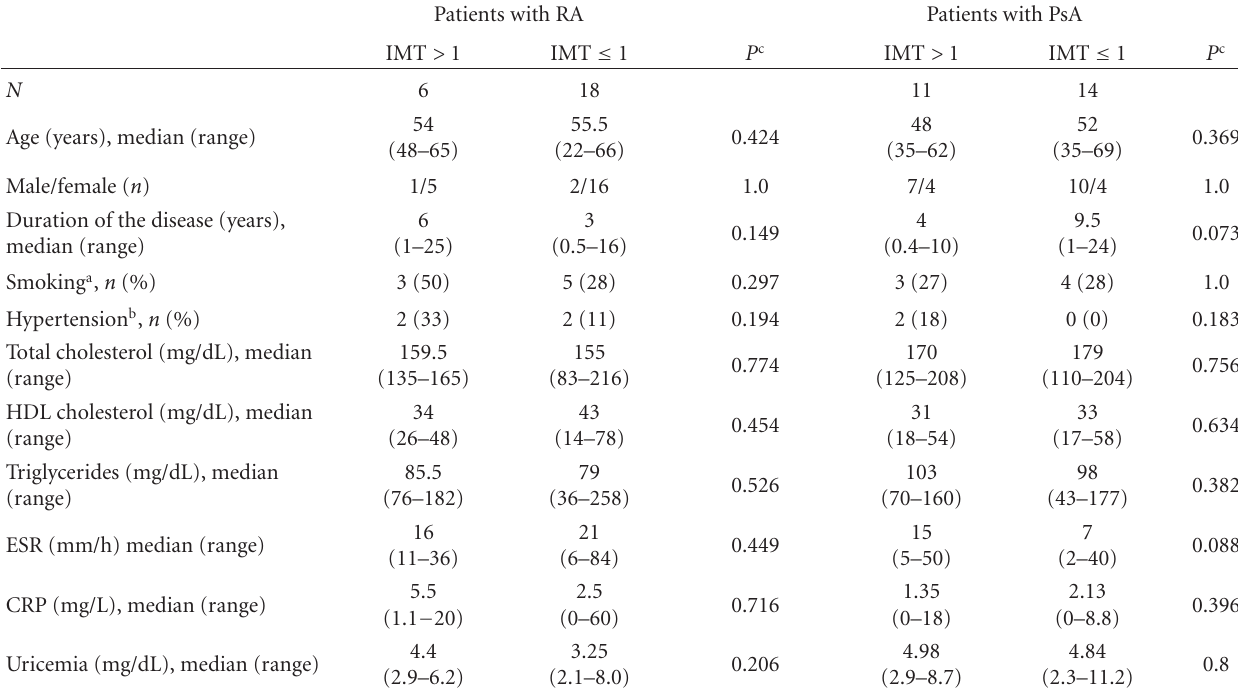
Table 1: Baseline characteristics of the 24 patients with rheumatoid arthritis (RA) and the 25 with psoriatic arthritis (PsA) divided according to intima-media thickness (IMT) values obtained by Echo-colour Doppler images.